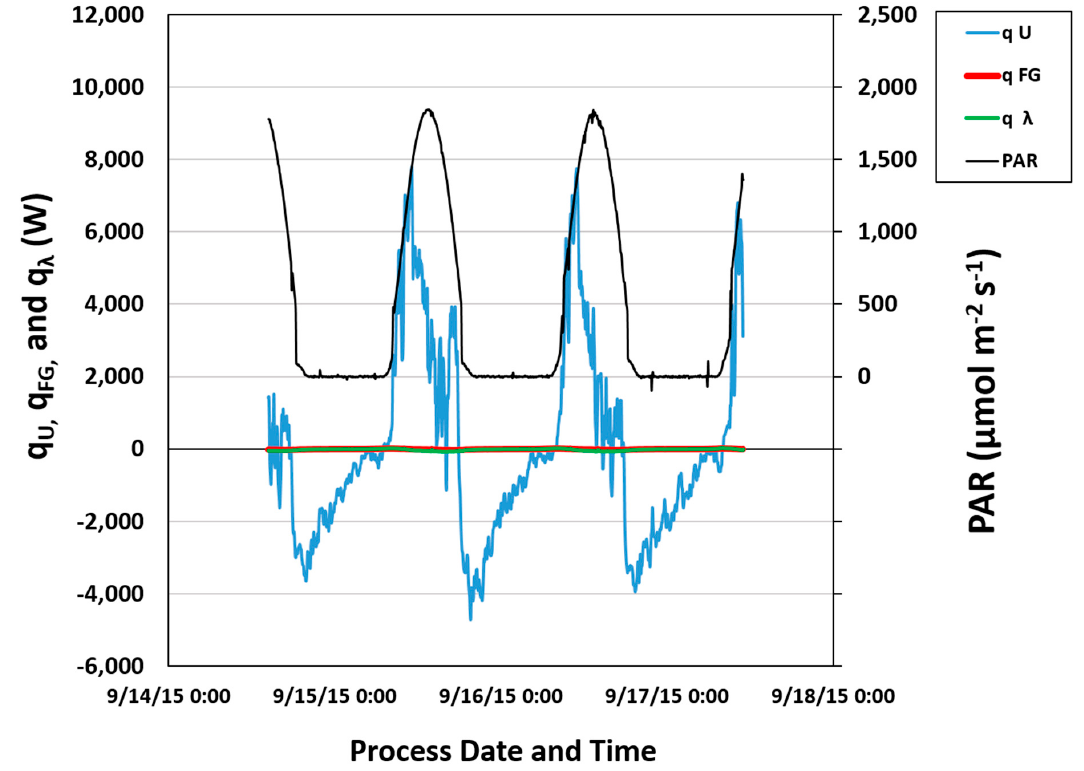
Figure 5. Heat contributions to the cyclic flow PBR and photosynthetically active radiation (PAR) vs. time. All q values are reported as thermal energy in watts (W). PAR is a measurement of solar radiation and is reported as a photon flux in µ mol m − 2 s − 1 .